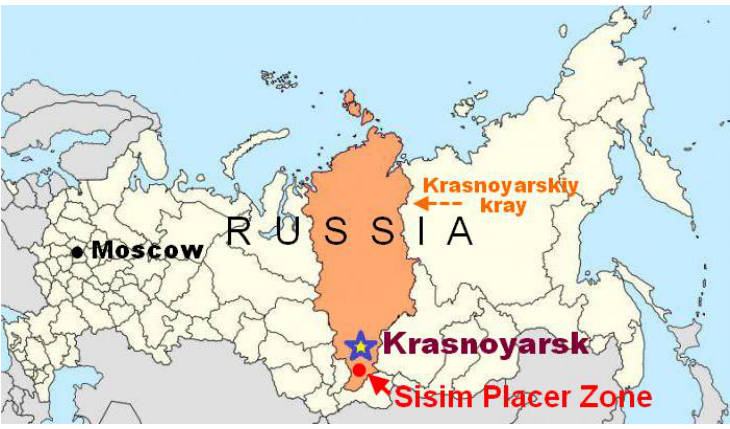
Figure 1. Map showing the location of the Sisim placer zone in the Krasnoyarskiy kray of the Russian Federation.